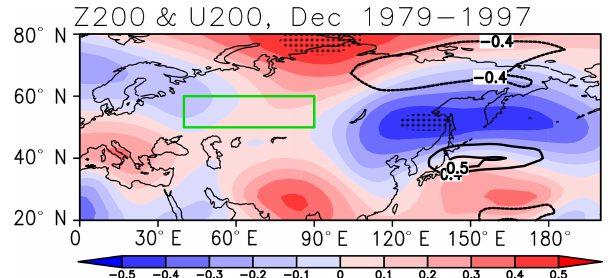
Figure 6. The CC between the SC ES and Z200 (shading) and U200 (contour) in December from 1979 to 1997. The black dots indicate the CC exceeded the 95% confidence level ( t test). The green box represents the ES area. The linear trend is removed.